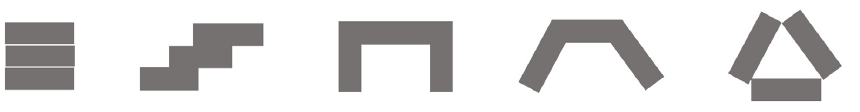
Figure 6. The experimental scheme to evaluate ADAM on space-borne PolSAR data.